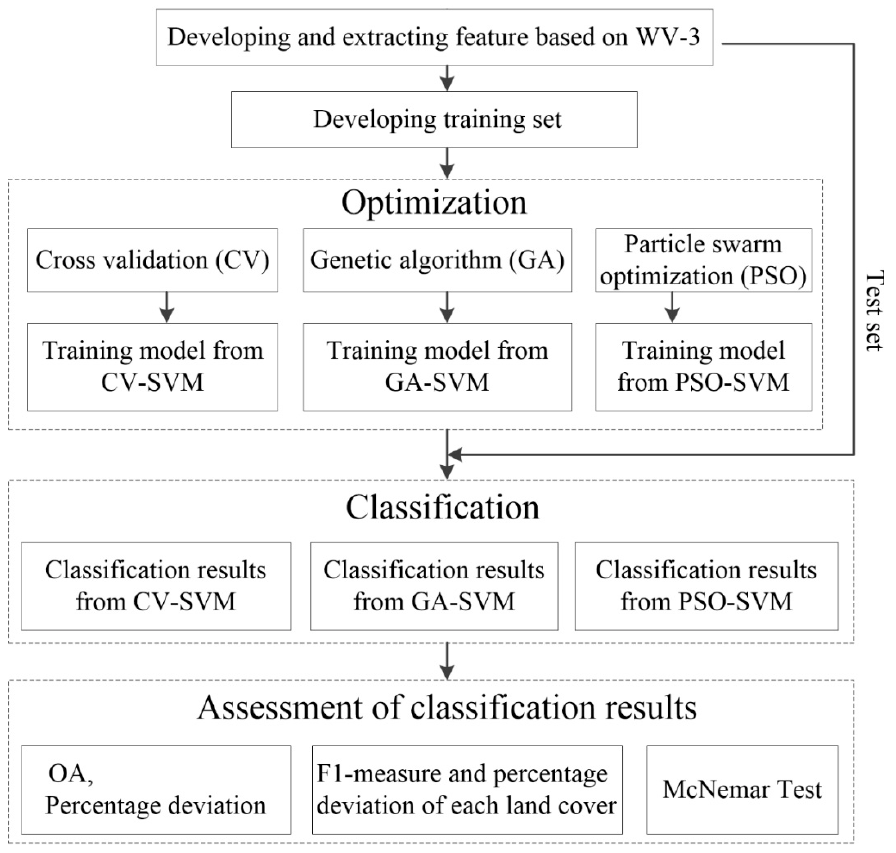
Figure 2. Overall flowchart of the methodology employed in this study.